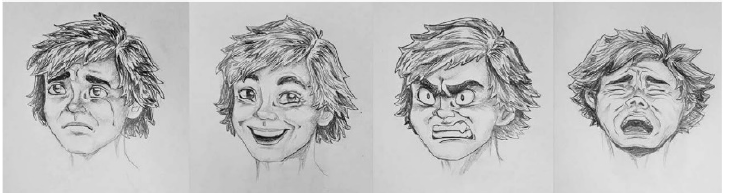
Figure 3. Emotional Scale of the PEI.